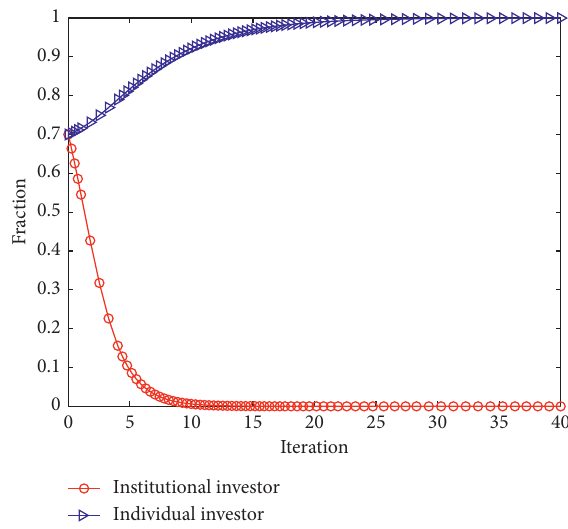
Figure 2: Simulation results for institutional and individual in- � 0 . 5, vestors using the parameters R M � 1 . 5, C M � 1, R 0 β � 0, and δ � 0 .